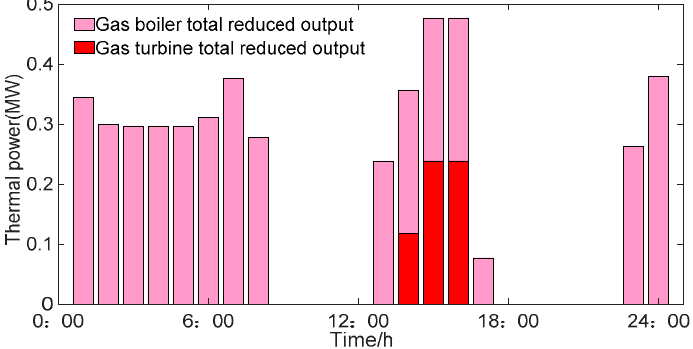
Figure 16. DR of users to the price of electricity.